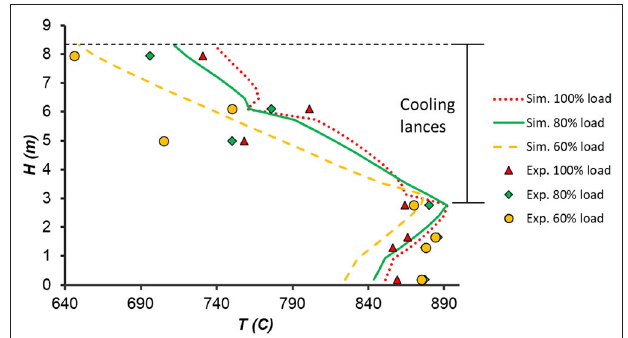
FIGURE 4 | Temperature profiles as predicted by the simulations and the experiments for the three examined loads: 100, 80, and 60%. The position of the cooling lances is also shown in the